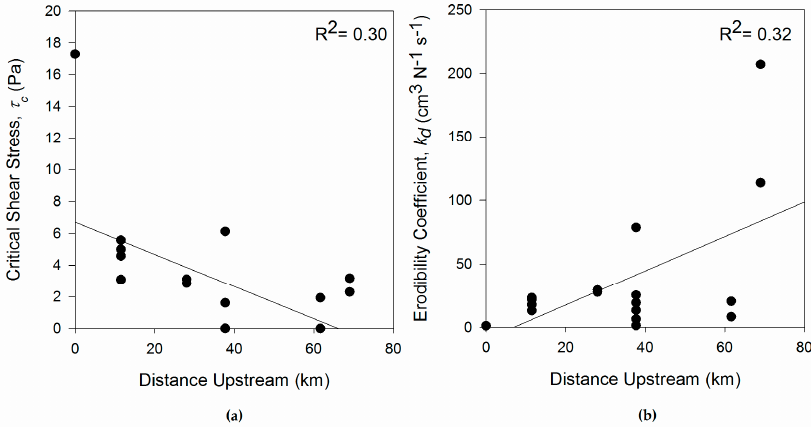
Figure 6. Regression for excess shear stress parameters determined using JETs: ( a ) τ c ; and ( b ) k d , versus distance upstream for Illinois River (IL-IR).